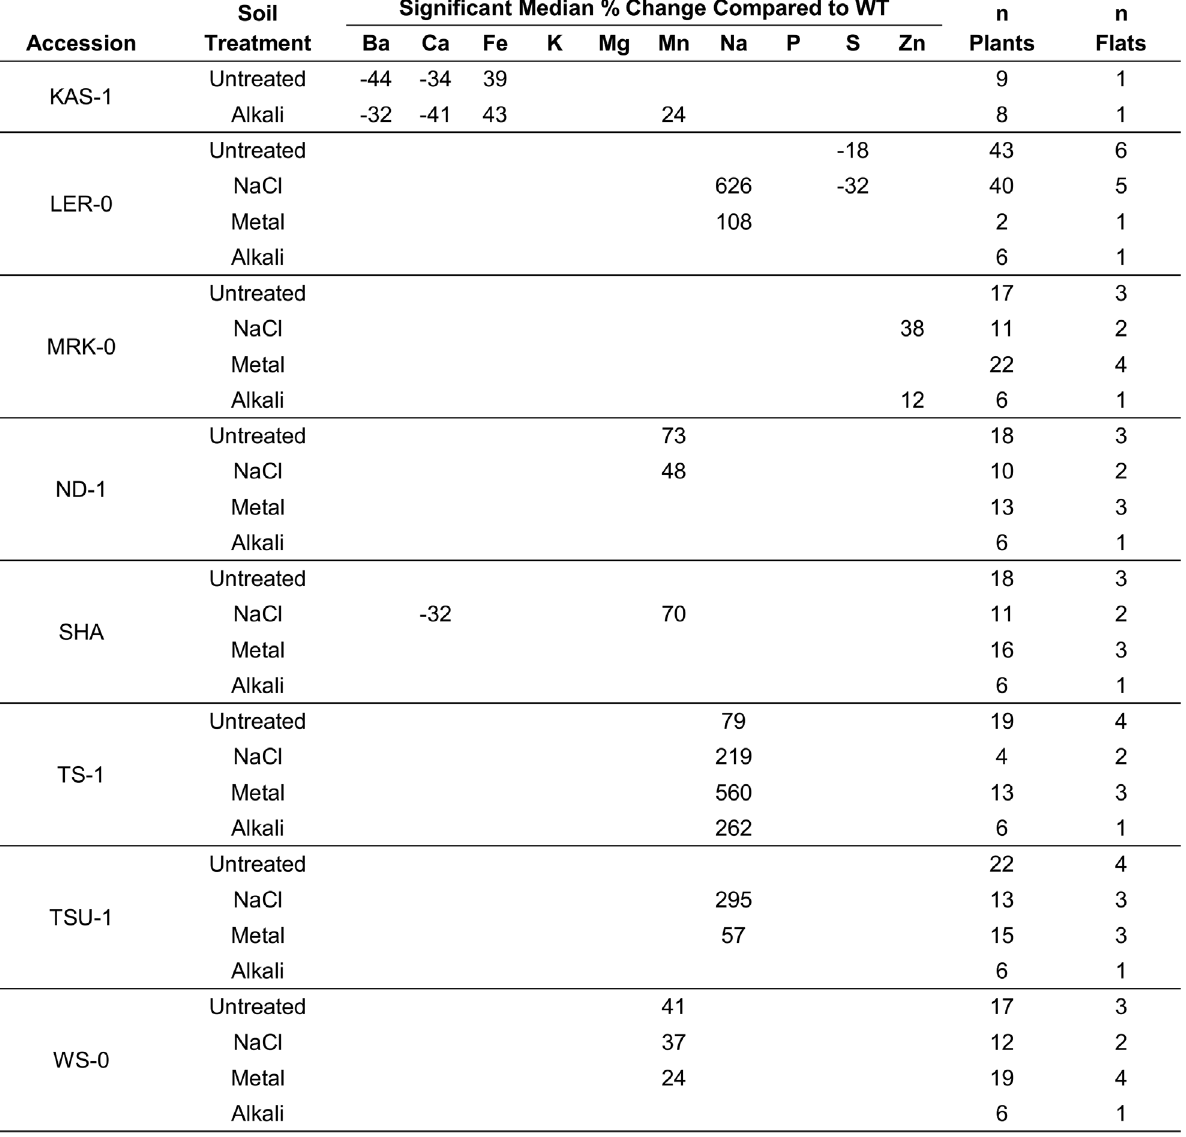
Figure 4. Percent changes in elemental concentrations relative to Col-0 reveal soil-dependent differences in natural variants. Data represents the median percent change in the concentration of elements with reproducibly significant differences between the experimental accessions and the Col-0 control accession. An ionomic change was considered significant if more than three standard deviations from the control mean and reproducible if consistent across multiple flats, soil conditions, or alleles.